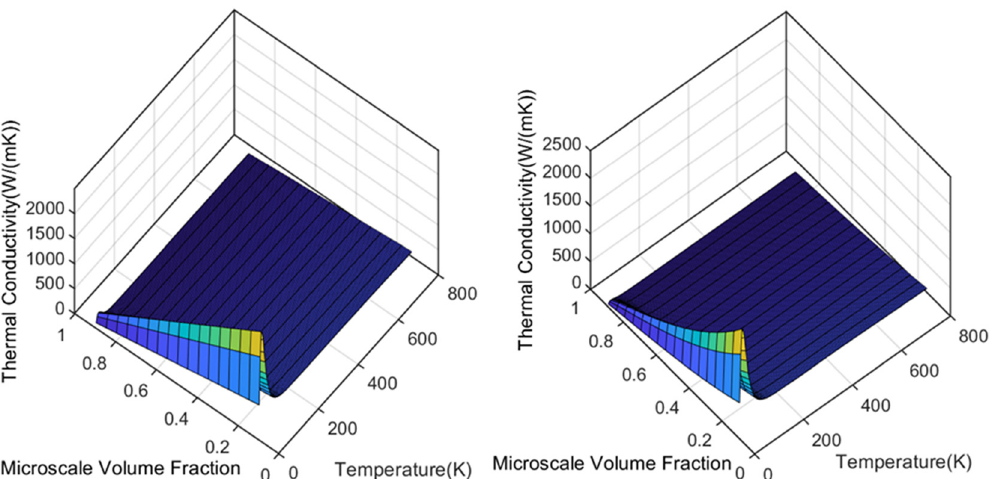
Figure 11: E ff ects of volume fraction of Nb 3 Sn fi lament at microscale and temperature on homogenized thermal conductivity, ( Left ) K 11 ⁎ , ( Right ) K K 22⁎ 33⁎ ( ) .